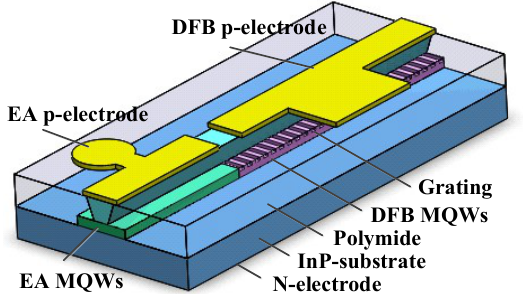
Figure 1. Schematic view of an EML laser using butt-joint technology.